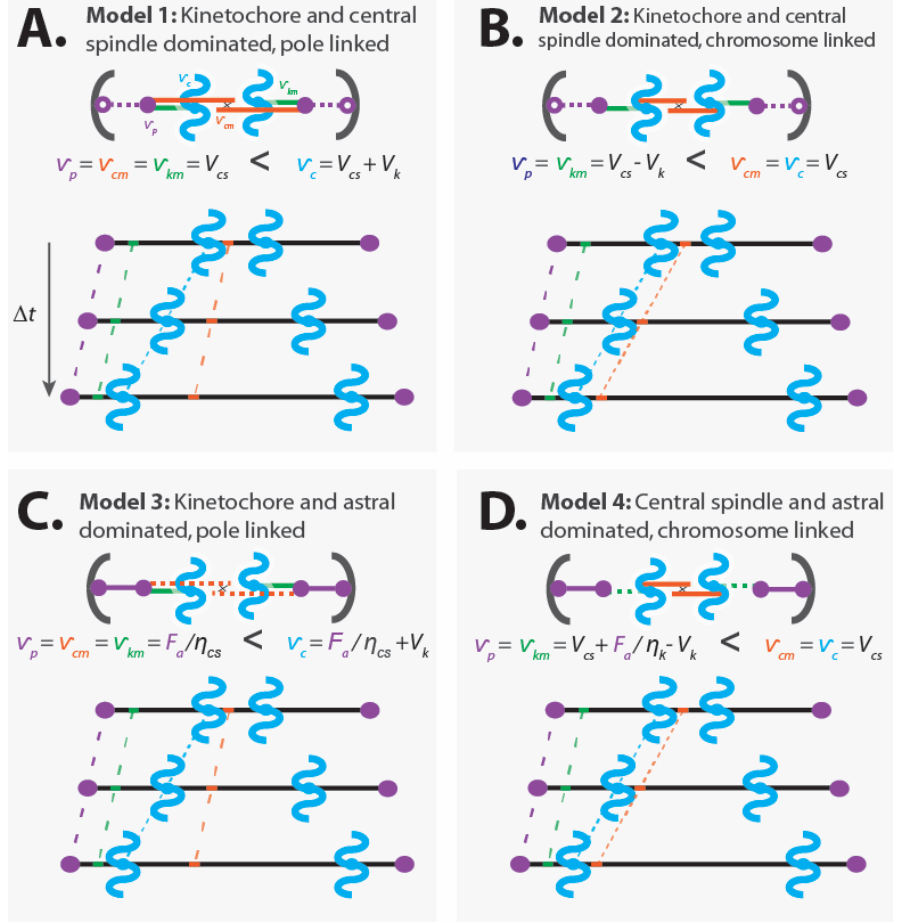
Figure 5. ( A ) In Model 1, the central spindle microtubules slide apart at their preferred speed, V cs , the kinetochore causes the kinetochore microtubules and chromatids to move relative to each other at its preferred speed, V k , and the central spindle microtubules are rigidly attached to the spindle poles. In this model, the speed that chromosomes move, v c , is faster than the speed that central spindle microtubules move, v cm (which is equal to the speed of spindle poles, v p , and kinetochore microtubules, v km ). ( B ) In Model 2, the central spindle microtubules slide apart at their preferred speed, the kinetochore causes the kinetochore microtubules and chromatids to move relative to each other at its preferred speed, and the central spindle microtubules are rigidly attached to the chromatids. In this model, chromosomes move at the same speed as central spindle microtubules. ( C ) In Model 3, the astral region generates substantial forces, F a , that pull the spindles poles apart with speed F a (where η cs is a measure of the strength of frictional forces between central spindle microtubules), η cs and the central spindle microtubules are rigidly attached to the pole and passively respond to the forces acting on them. The kinetochore causes the kinetochore microtubules and chromatids to move relative to each other at its preferred speed. In this model, chromosomes move faster than the central spindle microtubules. ( D ) In Model 4, the astral region generates substantial forces that are sufficient to perturb the dynamics of the kinetochore (where η k is a measure of the strength of kinetochore force generation), while the central spindle microtubules slide apart at their preferred speed. The central spindle microtubules are rigidly attached to the chromatids. In this model, chromosomes move at the same speed as the central spindle